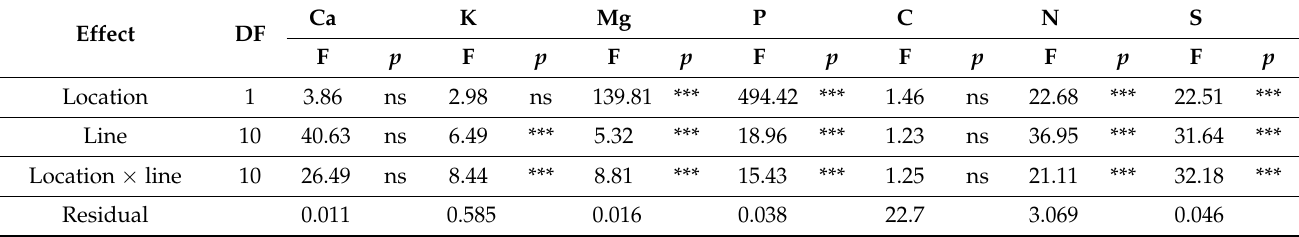
Table 1. Analysis of variance (F and p values) of the effects of location, genotype (CS lines, parent TM-1, and commercial cultivar AM UA48), and their interactions for cottonseed minerals (mg kg − 1 ) in cotton chromosome substitution lines (CS) in different locations (Florence, SC, 2013 and Starkville, MS, 2014).